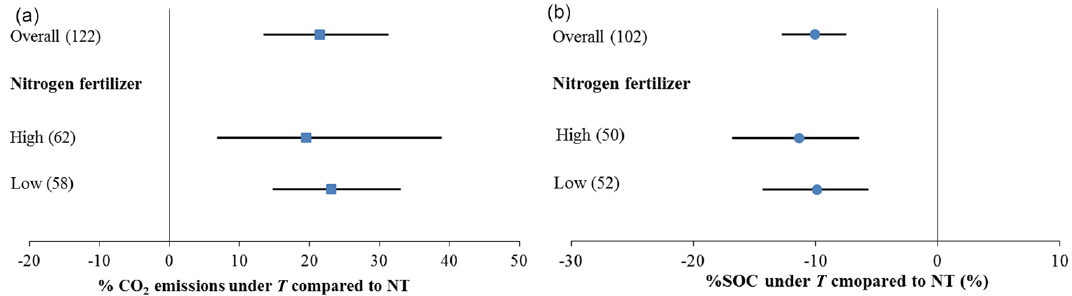
Figure 6. Percent change in (a) soil CO 2 emissions (b) and SOC in tillage ( T ) soil compared to no-tillage (NT) as a function of nitrogen fertilization (low < 100kgNha − 1 and high ≥ 100kgNha − 1 ) . The numbers in the parentheses indicate the direct comparisons of the meta- analysis. Error bars are 95% confidence